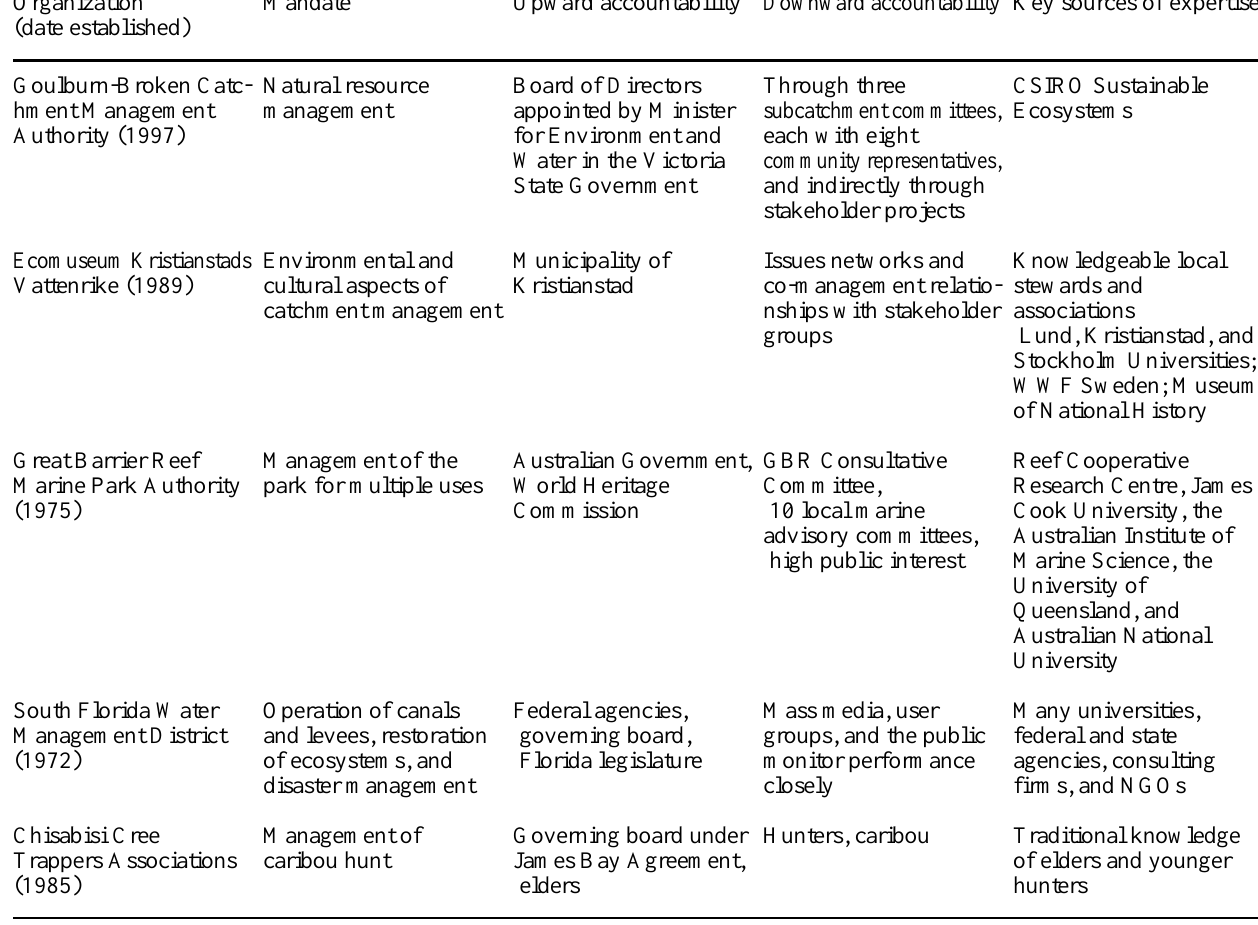
Table 2 . Comparison of some key organizations and their institutional relationships in a selected set of case